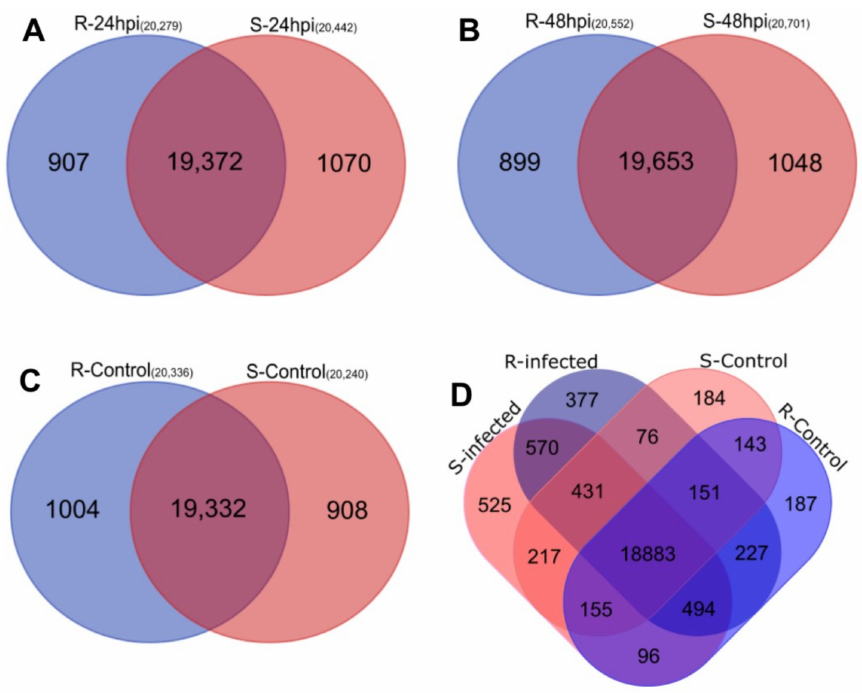
Figure 2. Venn diagrams presenting the overlap of expressed genes between resistant (Sp-R) and susceptible (Sp-S) wild tomato accessions. Pink circle represents Sp-R and blue is for Sp-S samples. ( A ) Comparison of P. parasitica infected Sp-R and Sp-S samples at 24 hpi. ( B ) Comparison of P. parasitica infected Sp-R and Sp-S samples at 48 hpi. ( C ) Comparison of mock inoculated R and S samples. ( D ) Combined comparison between all (mock and infected) Sp-R and Sp-S